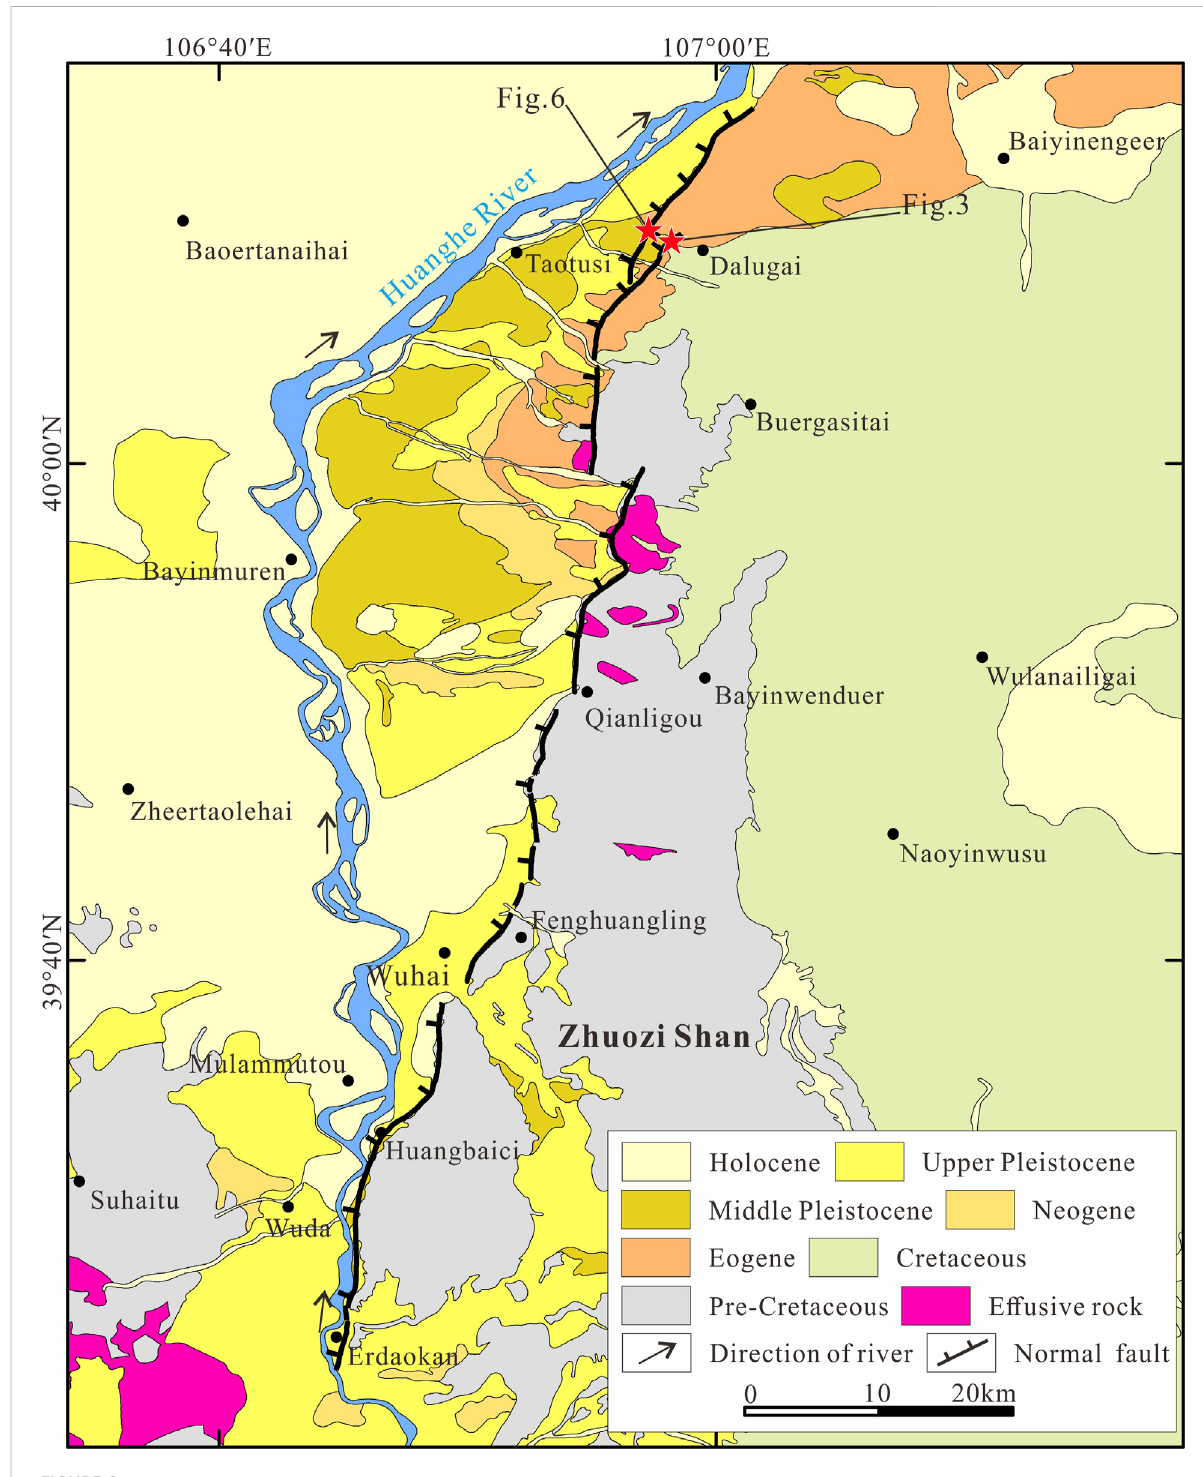
Geological map of the study area and its adjacent region, showing the distribution of bedrock lithology and the Zhuozishan West Piedmont